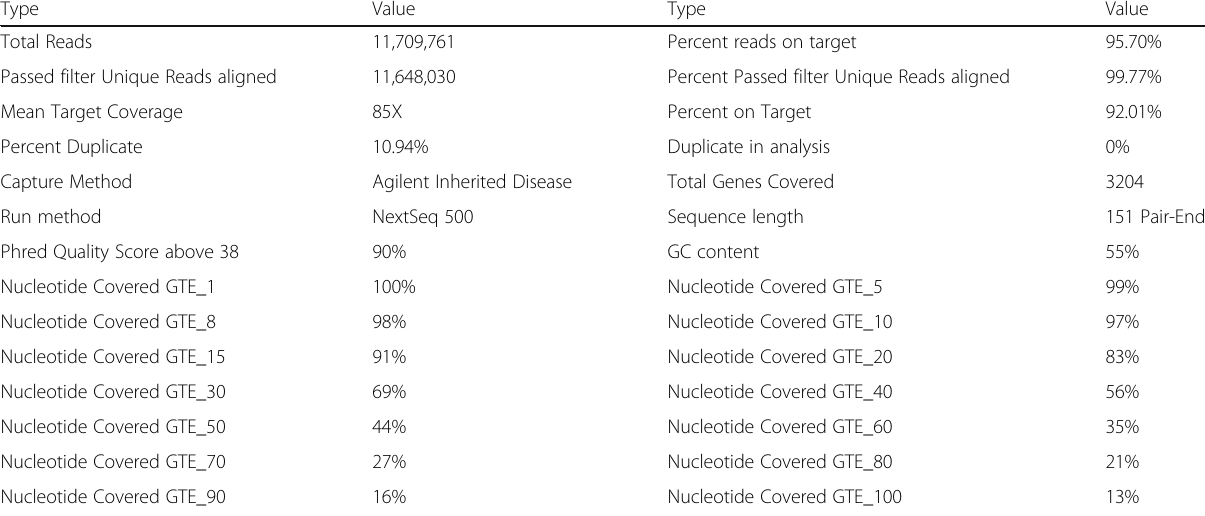
Table 1 Whole Exome Sequencing detail of coverage and number of reads